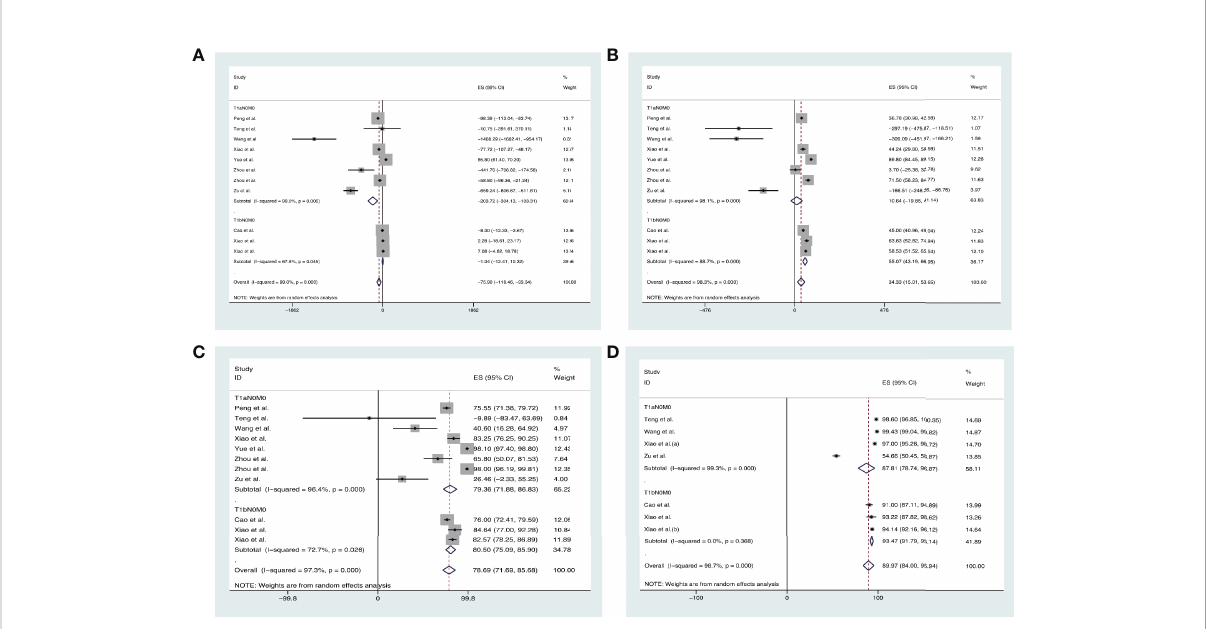
FIGURE 2 Forest plot of the effect of thermal ablations subgrouped by T1aN0M0 and T1bN0M0 on VAA (A) 3 months, (B) 6 months, (C) 12 months, and (D) 24 months after